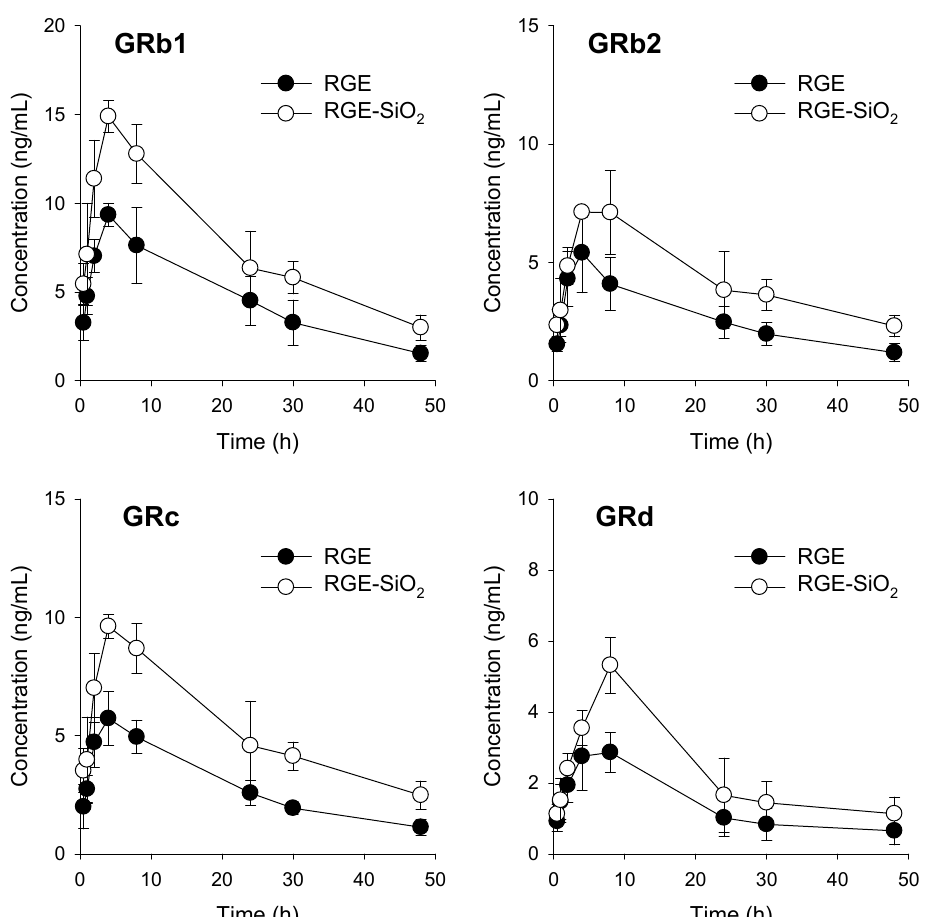
Figure 8. Plasma concentrations of ginsenoside Rb1 (GRb1), GRb2, GRc, and GRd after single oral administration of RGE (375 mg/kg) and solid dispersion formulation of RGE-SiO 2 (375 mg/kg as RGE) in rats. Data points represent the mean ± SD ( n = 4).